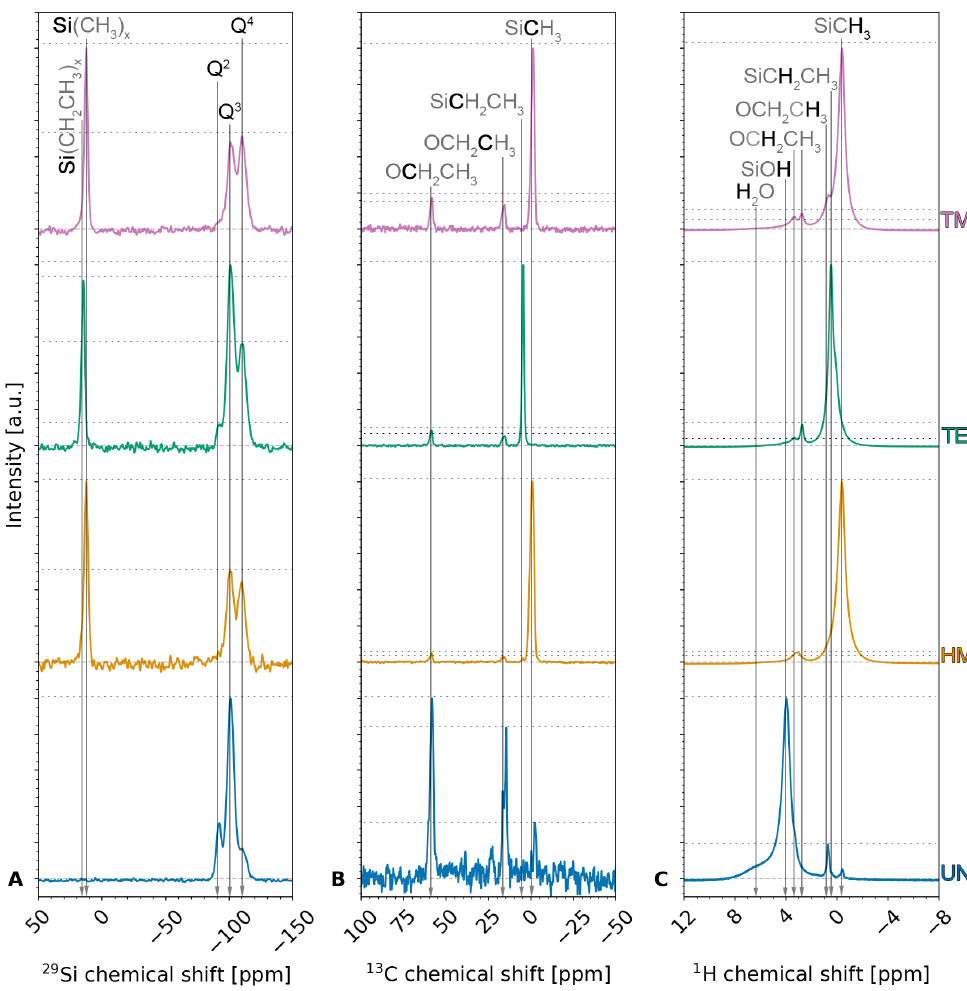
Figure 3. ( A ) 29 Si, ( B ) 13 C, and ( C ) 1 H NMR spectra of the unmodified UN (blue), hexamethyldisilazane-modified HM (orange), triethylchlorosilane-modified TE (green), and trimethylchlorosilane-modified TM samples (pink). A vertical shift was used for better visibility and a grey dotted baseline is shown.